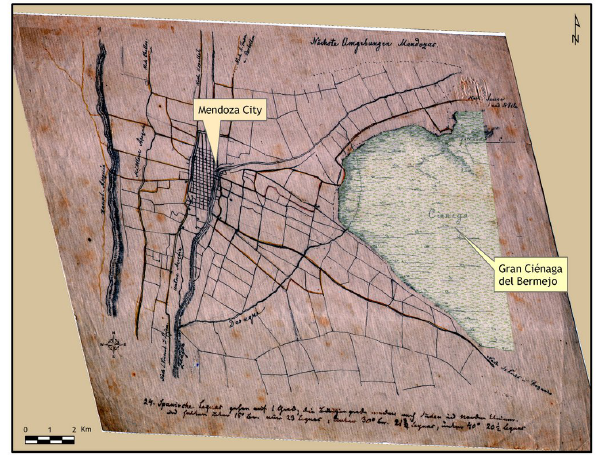
Fig. 6. The Bermejo Wetland in 1861 according the Herman Burmeister map (Library of the Museum of Mendoza Foundational